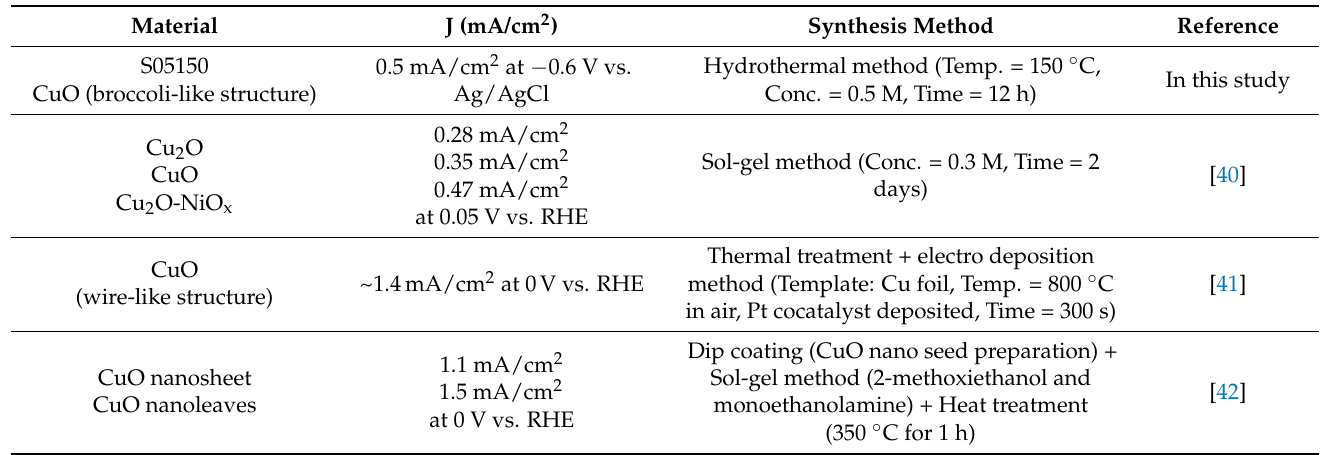
Table 2. The comparison of photoelectrochemical water splitting efficiency of CuO broccoli-like structure (S05150) and other